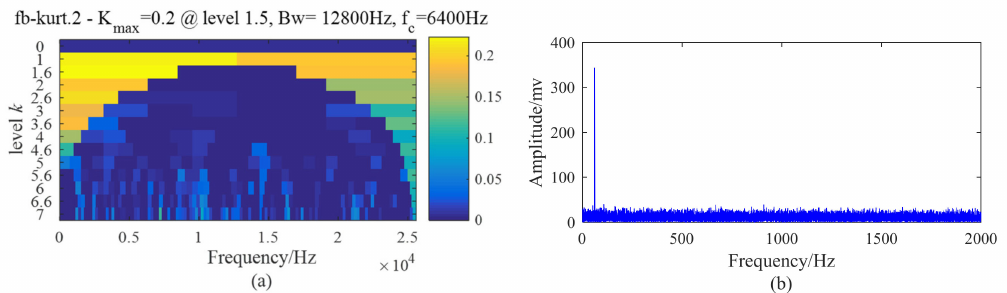
Figure 18. The diagnosis result of the simulation signal of the bearing with the inner race fault processed by the Fast Kurtogram (FK) method: ( a ) the kurtogram result; ( b ) the squared envelope spectrum result.